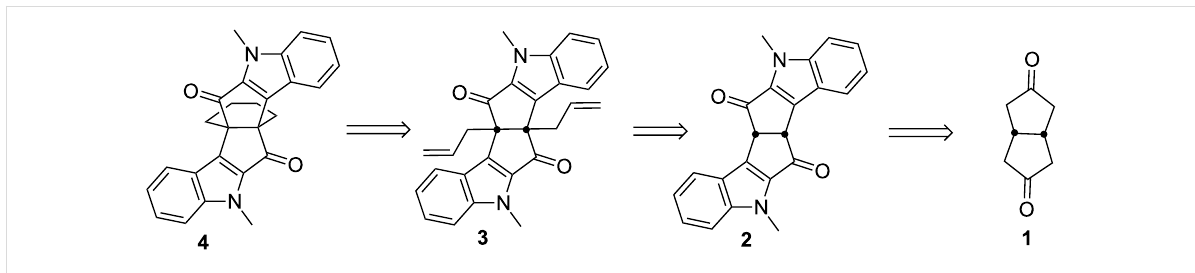
Figure 3: Retrosynthetic strategy to indole-based propellane 4 .